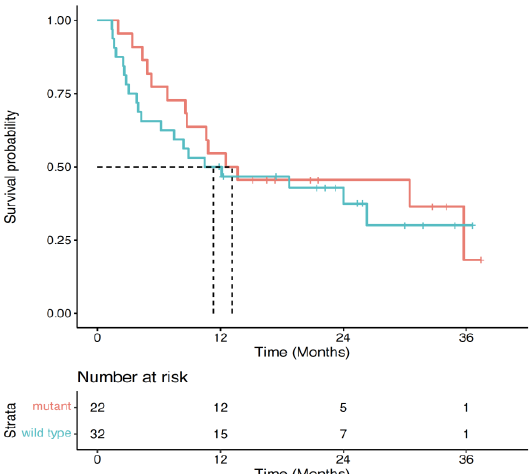
Figure 3. Overall survival by treatment for first and second-line systemic therapy. ( A ) First-line overall survival by type of systemic therapy regimen. ( B ) Second-line overall survival by type of systemic therapy regimen.